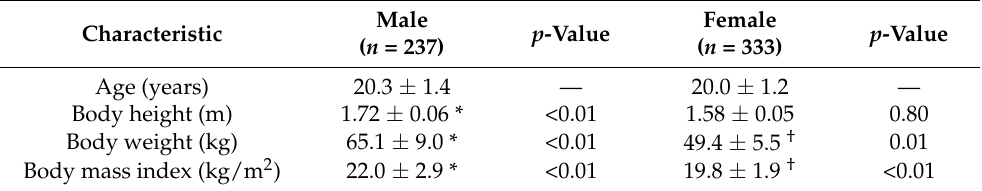
Table 1. Participants’ characteristics.